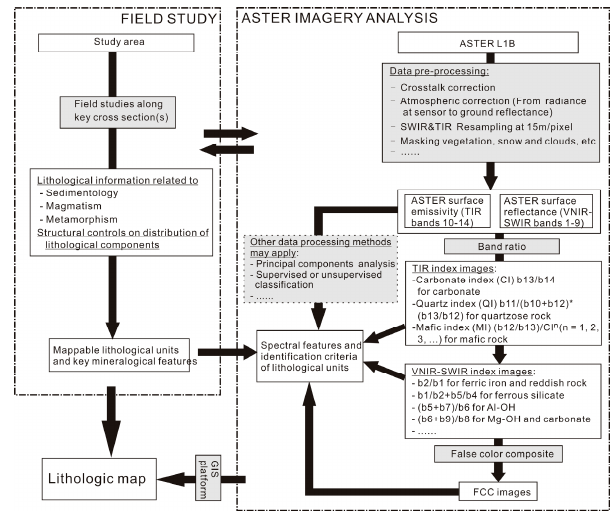
Figure 3. Generalized procedures of lithologic mapping based on combined studies of field geology and ASTER data analysis.